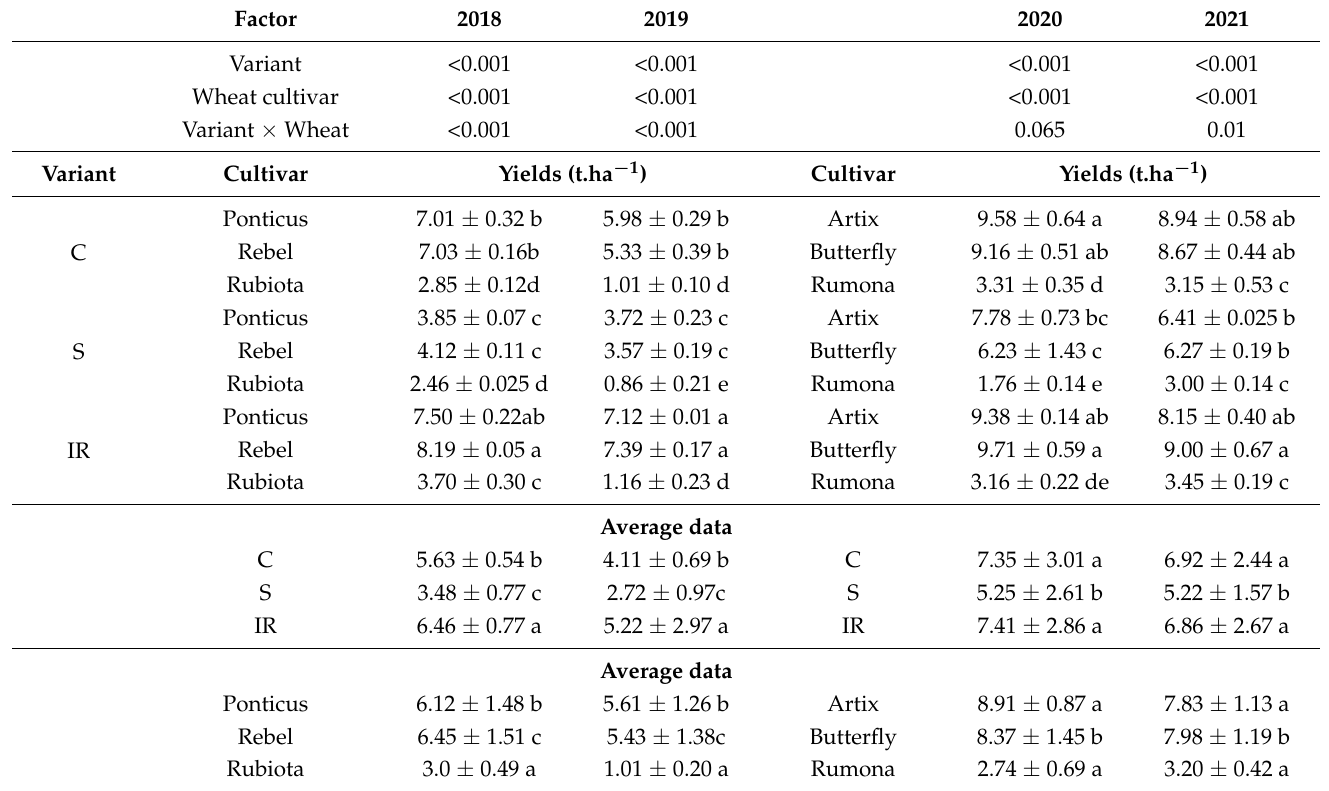
Table 3. The results of the analysis of the variance (ANOVA) of grain